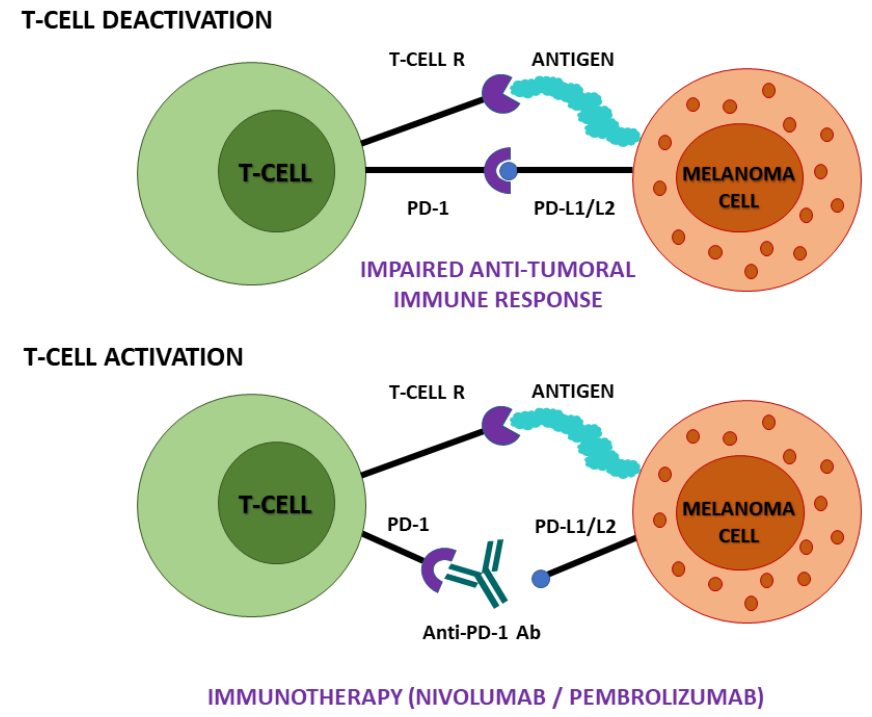
Figure 1. Immunotherapy of PD-1–PD-L1/L2 axis blockade—mechanism of action. Anti-PD-1 monoclonal antibodies nivolumab and pembrolizumab enhance the anti-cancer response by blocking the binding of PD-1 to PD-L1/L2, thus activating T-cells to eradicate cancer cells. Abbreviations: PD-1, programmed cell death 1; PD-L1/L2, programmed cell death ligand 1/2; T-cell R, T-cell receptor; Ab, antibody.